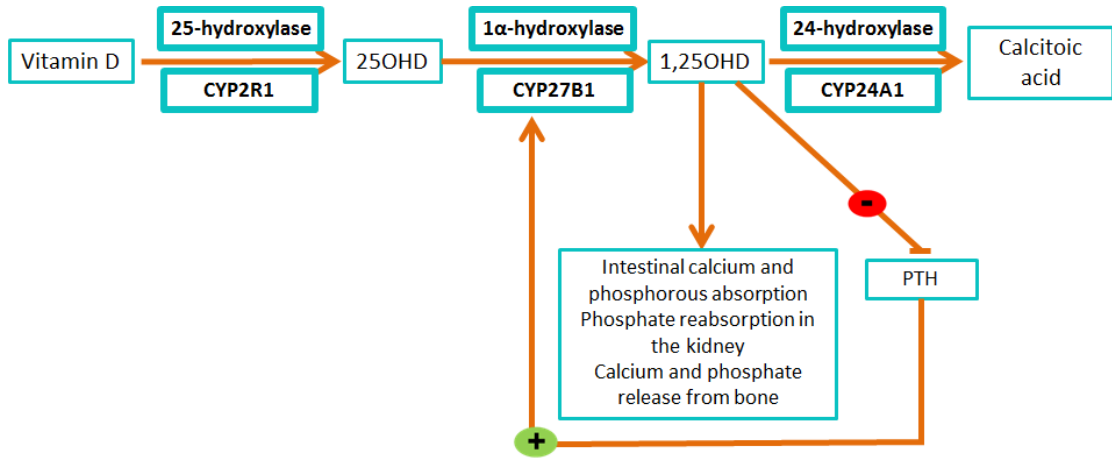
Figure 4. Vitamin D activation and deactivation by the cytochromes